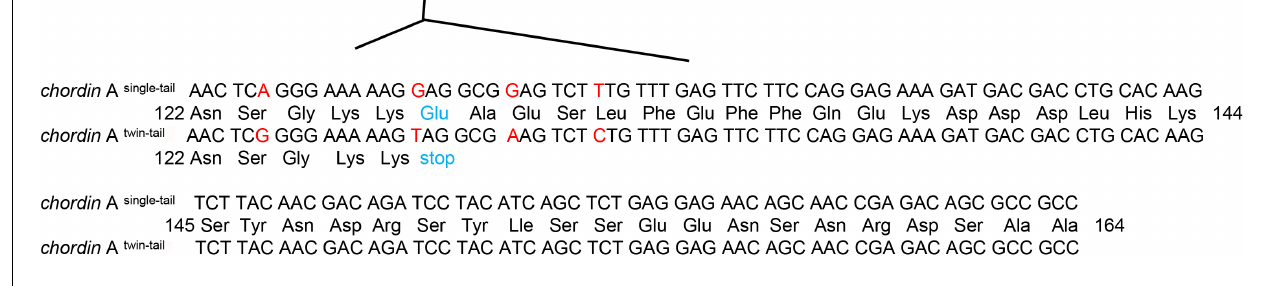
FIGURE 2 | The chordin A wt and chordin A E 127 X amino acid sequences in single-tail and twin-tail fish. Diagram shows the composition of chordin A; exons are shown as light green boxes. The twin-tail-specific mutation changes a glutamic acid codon (GAG) to a stop codon (TAG) at amino acid position 127 of the 4 th exon; the mutated amino acid is indicated by red letters. The sequenced exons (1 st to 6 th ) are located in the horizontal bracket. The lower panel shows the amino acid composition of the 4 th exon, which includes the mutation.